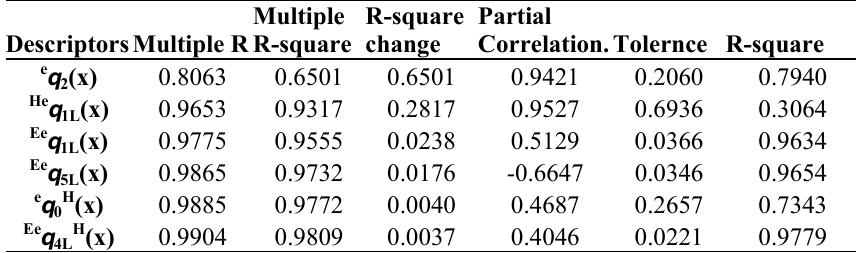
Table 17. (cid:147) Redundancy(cid:148) of total and local quadratic indices used as independent